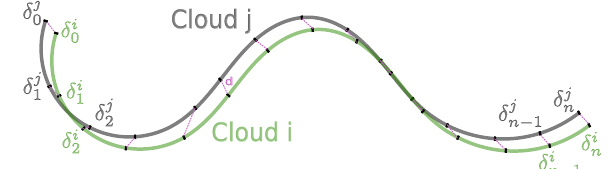
Figure 2: Illustration of the distance d separating the drift δ n control time T c between two mobile data for the average drift computation DM .